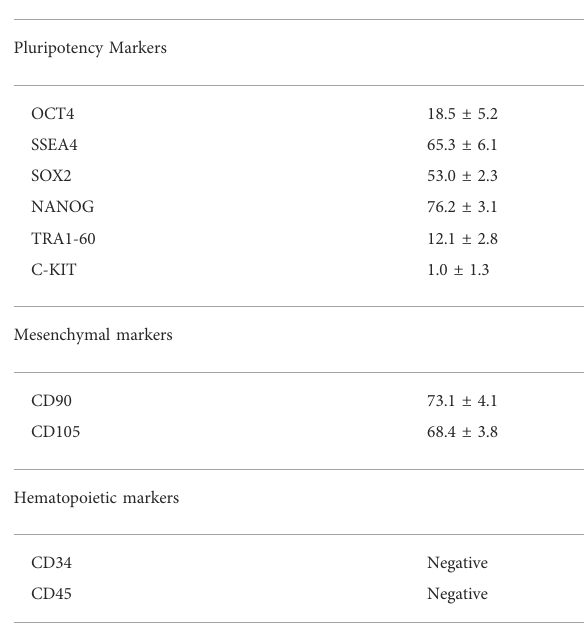
TABLE 2 Phenotypic characterization of